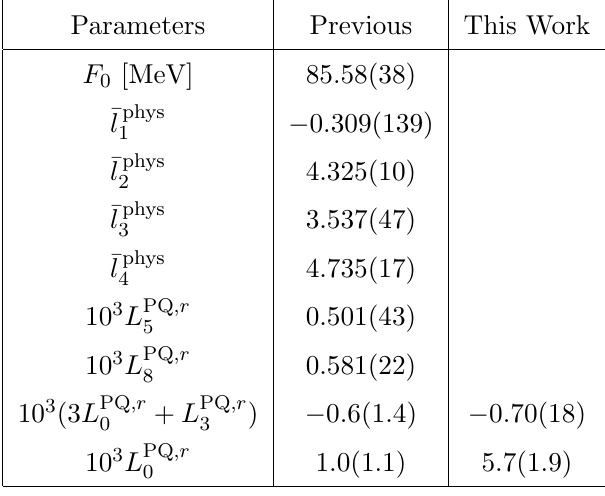
g are taken from i